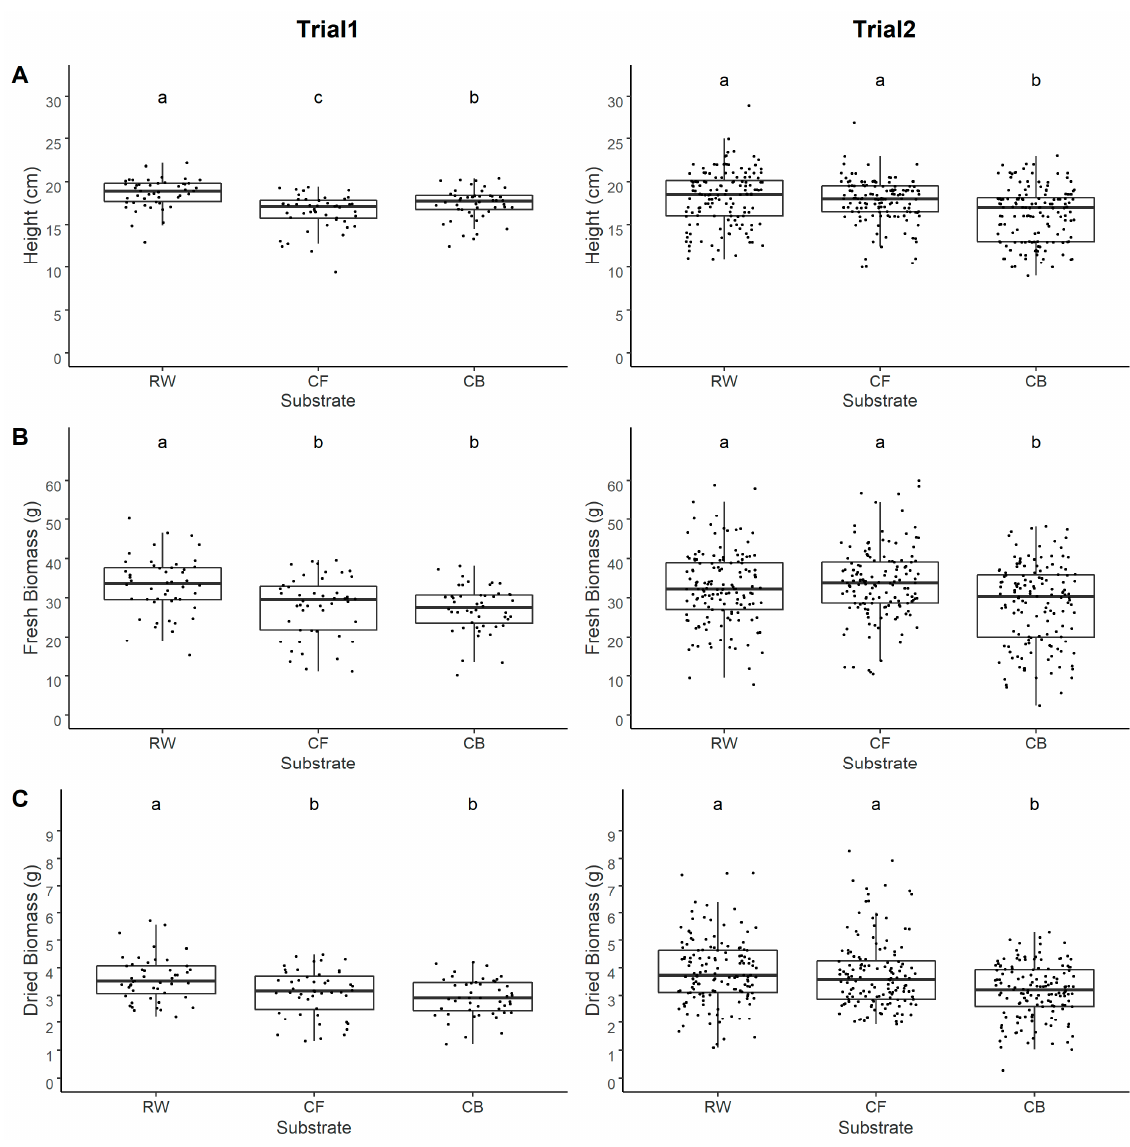
Figure 3. Boxplot of Euphorbia peplus height ( A ), fresh biomass ( B ), and dried biomass ( C ) according to the substrate (RW: rockwool; CB: clay beads; CF: coco fiber) in two independent experiments. Student or Wilcoxon’s comparison test was applied with 95% confidence; means or medians that do not share a letter are significantly different. Trial 1: N = 48 plants. Trial 2: N = 144 plants. Table 1. Mean and standard deviation of total ingenol (mg/kg) measured in aliquots of 24 plants in two independent hydroponic cultivations of E. peplus in three substrates (rockwool, coco fiber, and clay beads). Student’s comparison of means was applied with 95% confidence; means that do not share a letter are significantly different.